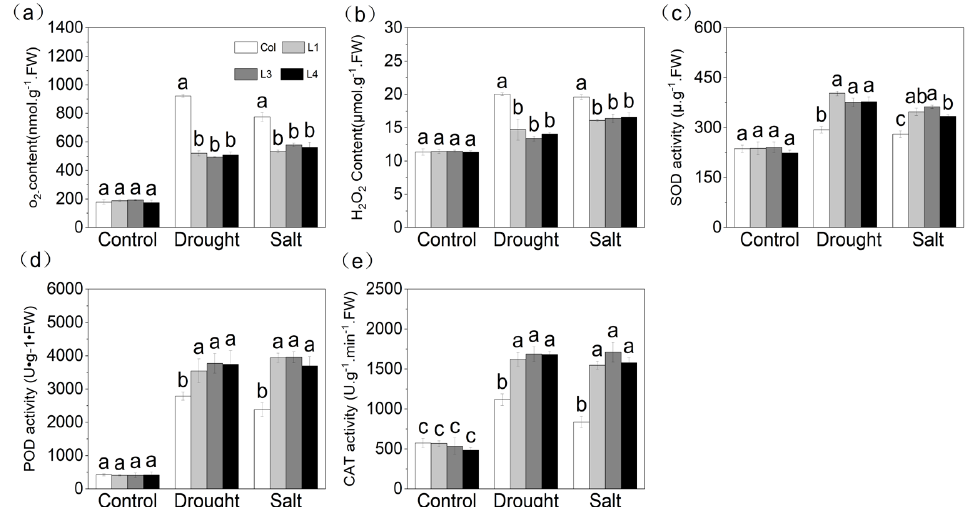
Fig. 6: Analysis of reactive oxygen species (ROS) and antioxidant enzyme activities in transgenic and wild-type A. thaliana under drought and salt treat- ments. (a) Superoxide anion (O 2 - ) level in transgenic and wild-type A. thaliana under drought and salt treatments. (b) Hydrogen peroxide (H 2 O 2 ) level in transgenic and wild-type A. thaliana under drought and salt treatments. (c) SOD activity in transgenic and wild-type A. thaliana under drought and salt treatments. (d) POD activity in transgenic and wild-type A. thaliana under drought and salt treatments. (e) CAT activity in transgenic and wild- type Arabidopsis under drought and salt